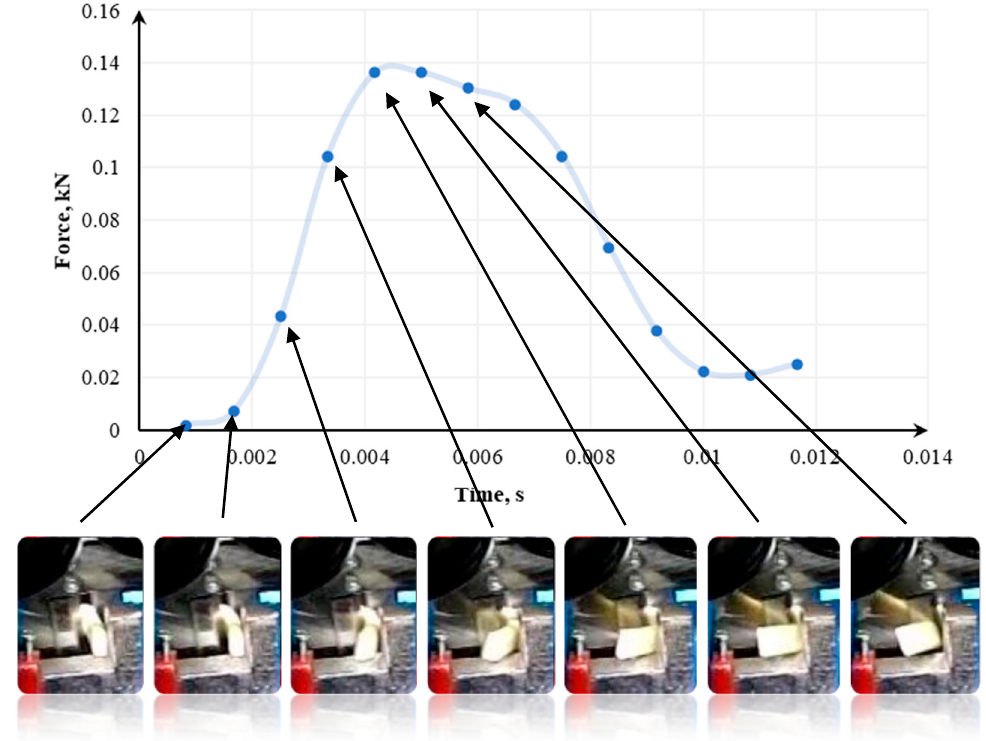
Figure 16. Momentary force values during grinding of a single polypropylene sample in a vertical arrangement using a 75° knife.